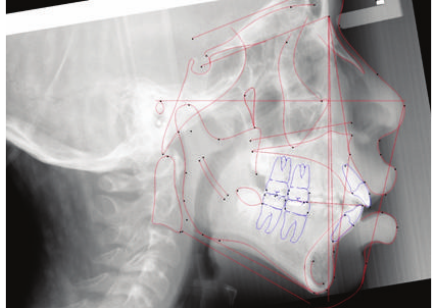
Figure 12: Stage 1: Orthodontic Treatment Cephalometric Radio- graph.